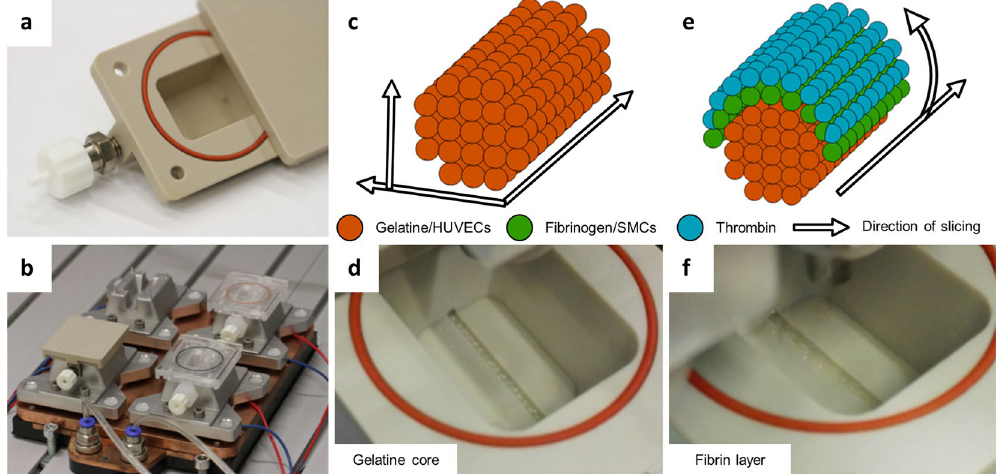
Figure 4. Printing procedure to manufacture vascular channels in custom-made bioreactors. The custom-built bioreactor has Luer lock adapters and an airtight silicon sealing ( a ). The printing process starts with cooling the reactor on the platform for optimal gelation timing ( b ). The gelatine core is printed by following a printing pattern, which is created by slicing the channels horizontally and calculating the droplets in a grid for each longitudinal section ( c ). To print the gelatine core, a single printer head is used at 37 °C ( d ). For the surrounding fibrin layer, the printing pattern is calculated by slicing the channel lengthwise and defining droplet positions in angular steps around the channel outline of each cross section ( e ). Two printer heads are used, filled with fibrinogen and SMCs alternatingly, as well as thrombin as a crosslinker ( f